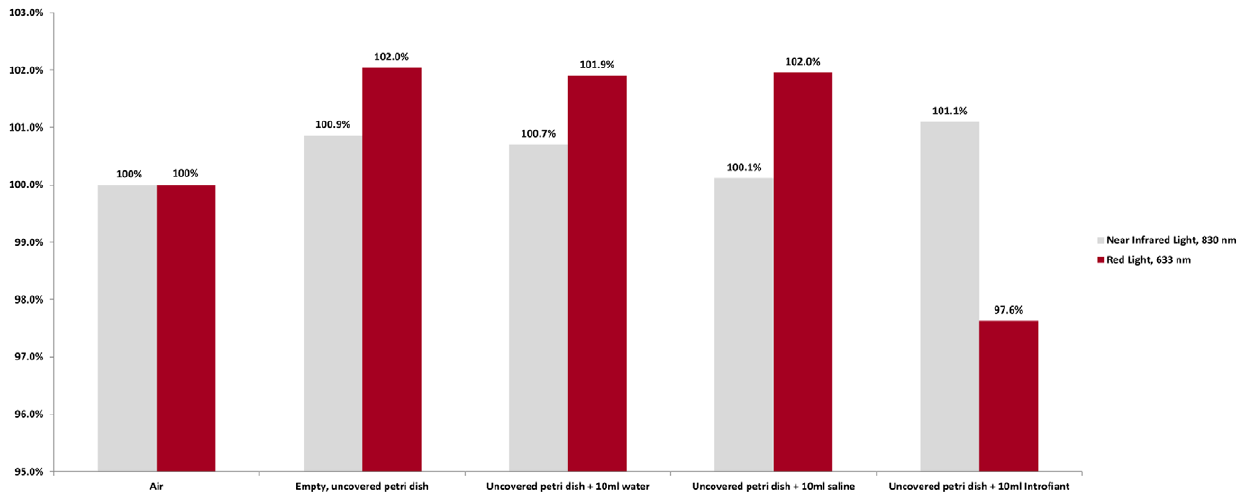
Figure 5. Percent Penetrance of Light through Various Media. Water, saline, and cadaver fixative (Introfiant) have little effect on the transmission of near infrared and red lights.